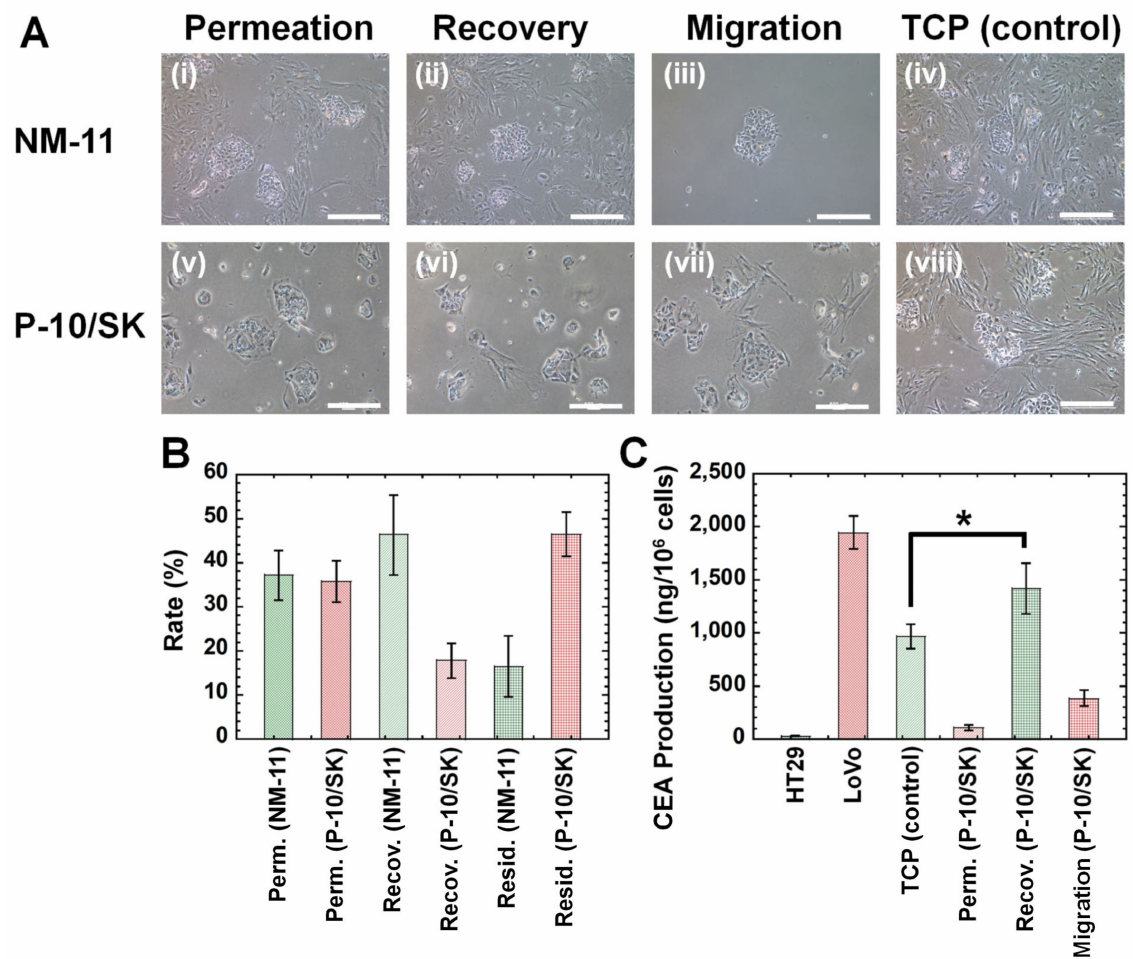
Figure 7. Morphologies, filtration characteristics, and CEA production of primary colon carcinoma (M-24) cells derived from patient colon tumor tissues after filtration via NM and PLGA/SK filters. ( A ) Morphologies of primary colon carcinoma (M-24) cells derived from the patient’s colon tumor tissues in permeation solution ( i , v ), recovered solution ( ii , vi ), and migrated cells ( iii , vii ) through the NM-11 ( i – iii ) and PLGA-10/SK (P-10/SK) ( v – vii ) filters. The morphologies of primary colon carcinoma (M-24) cells cultured on TCP dishes (control) are also shown ( iv , viii ). The scale bar indicates 100 µ m. ( B ) Residual rate (Resid.), recovery rate (Recov.), and permeation rate (Perm.) of primary colon carcinoma (M-24) cells from the patient colon tumor tissues through NM-11 and PLGA-10/SK (P-10/SK) filters. ( C ) CEA production of primary colon carcinoma (M-24) cells derived from patient colon tumor tissues before (cell culture on TCP) and after permeation through PLGA-10/SK (P-10/SK) filters in permeation solution (Perm.), recovered solution (Recov.), and migrated cells (Migration). CEA production of HT-29 and LoVo cells cultured on TCP dishes is also shown (control). * p <